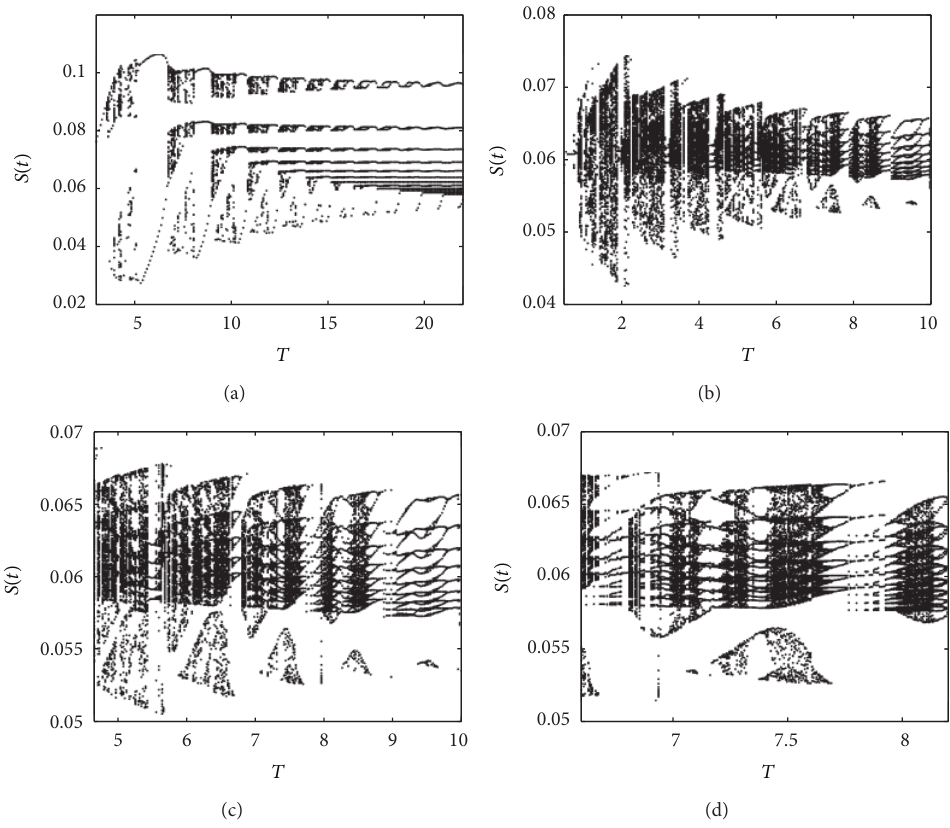
Figure 4: Bifurcation diagrams of model (4) with respect to bifurcation parameter 𝑇 . Here 𝑝 max = 0.75 and all other parameter values are given in Table 1. (a) 𝜃 = 0 which are reproduced from [9]; (b) 𝜃 = 0.2 ; (c and d) a magnified part of Figure